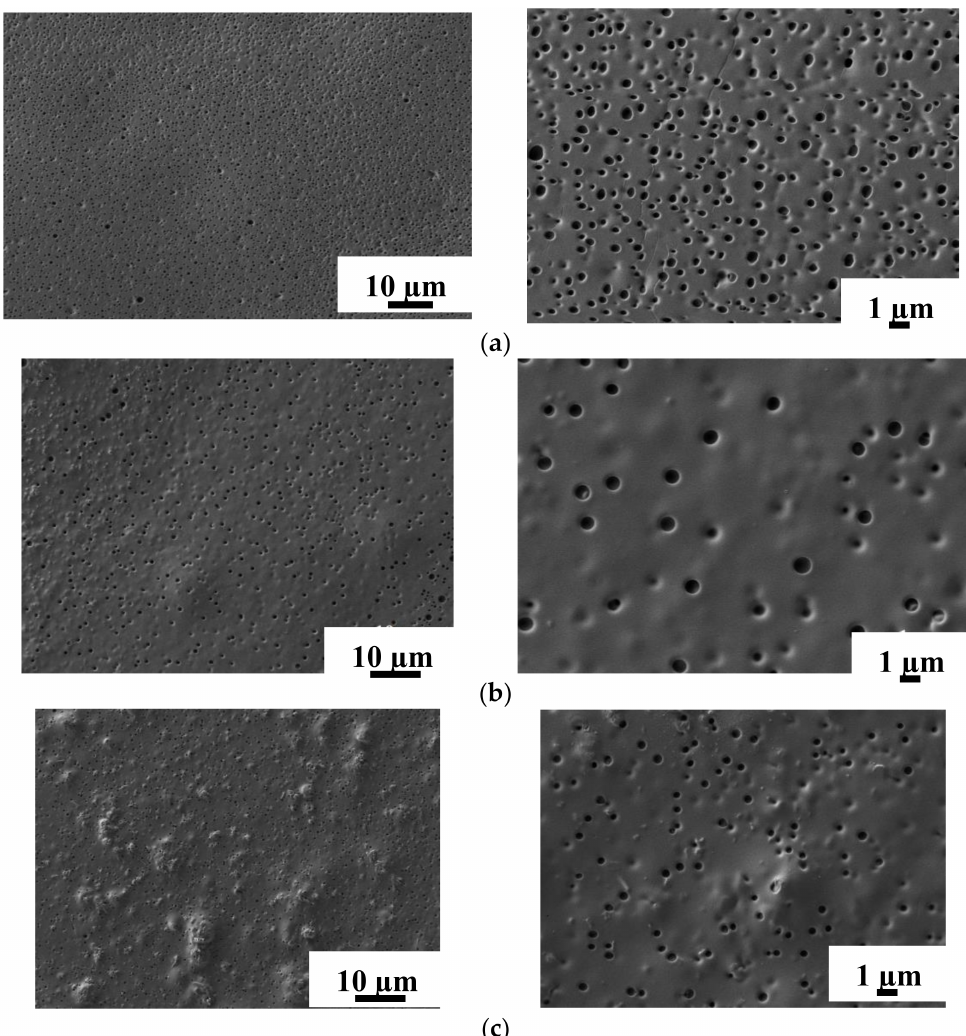
Figure 15. SEM micrographs of the surface at different magnifications of nanofiltration-supported ( a ) PIM-1, ( b ) PIM-1/MIL-125, and ( c ) PIM-1/MIL-140A